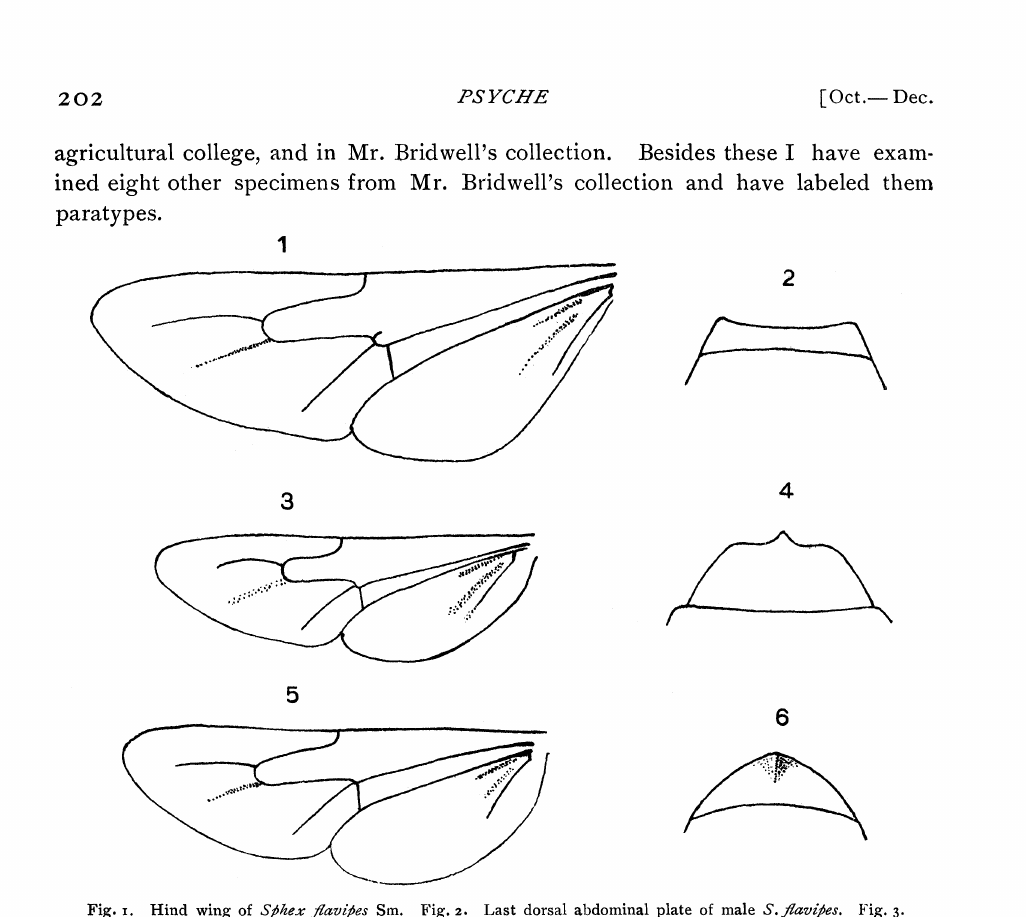
Fig. Hind wing of Sphe,v 3avifes Sin. Fig. Last dorsal abdominal plate of male S.flavipes. Fig. 3. Hind ing of S. 3ridwelli. Fig. 4. Last ventral abdominal plate of male S. nudus. Fig. 5. Hind wing of 5‘. nudus. Fig. 6. Last dorsal abominal plate of male 5".